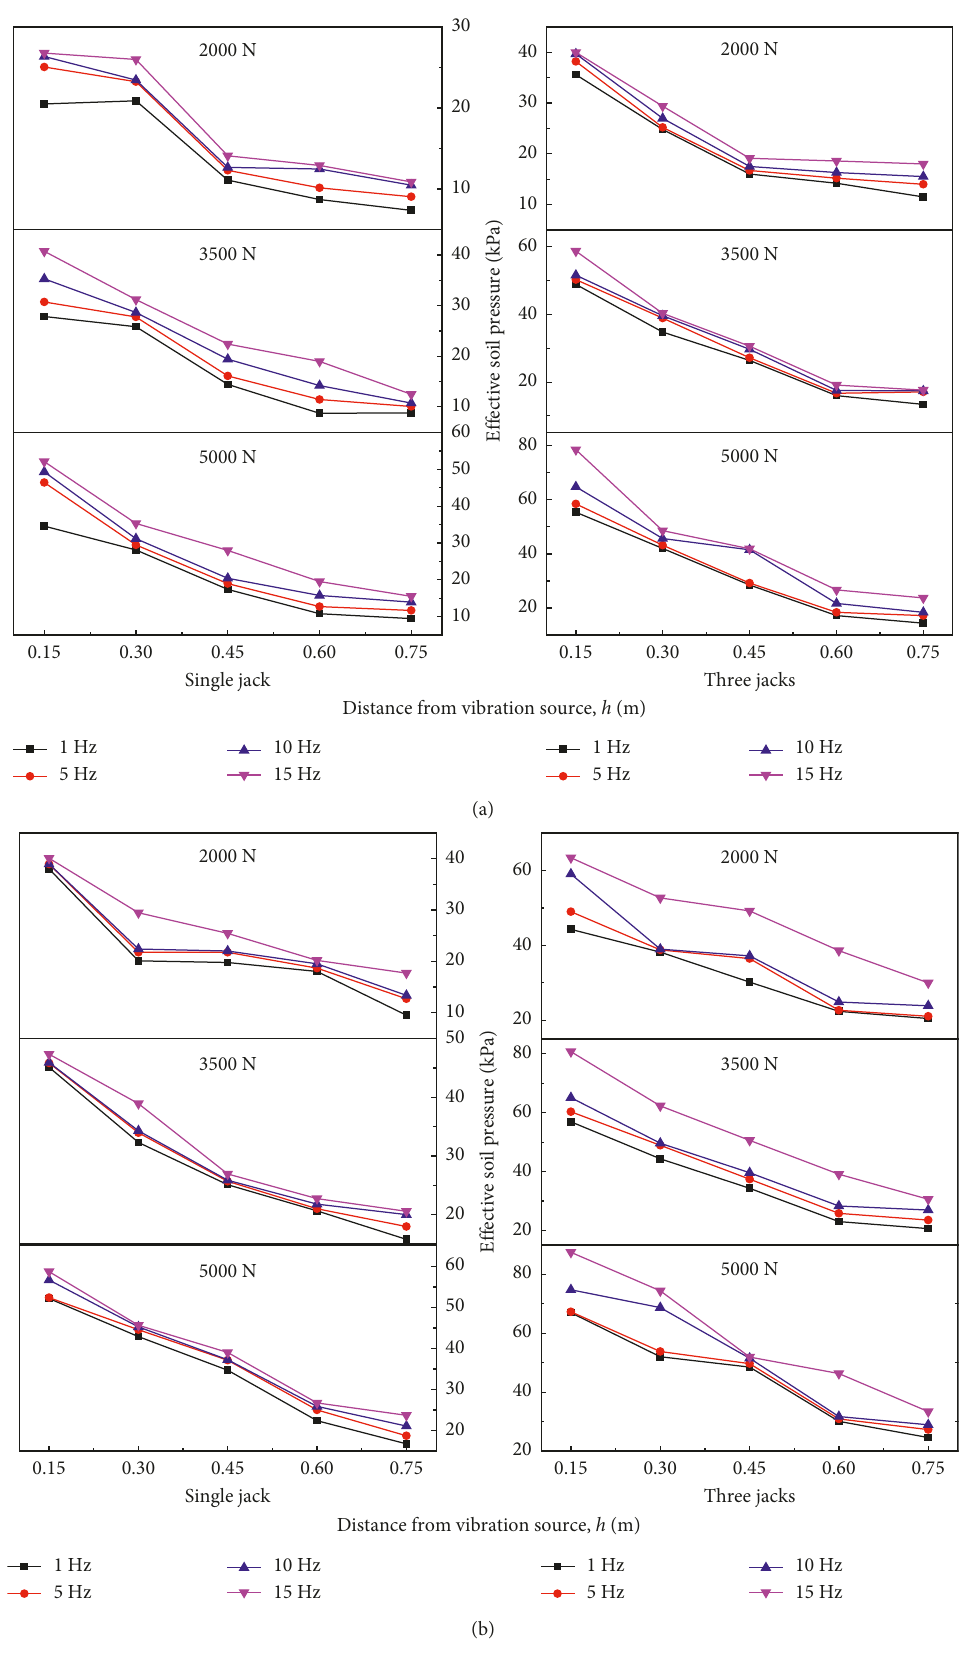
Figure 14: Comparison of the effective soil pressure under different excitation loads under the single jack and three jacks conditions: (a) sand bag and (b)